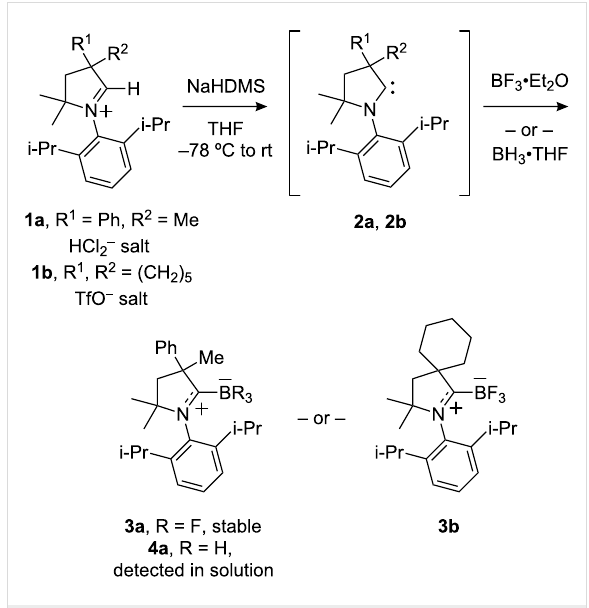
Most of the first generation carbene-boranes have been made